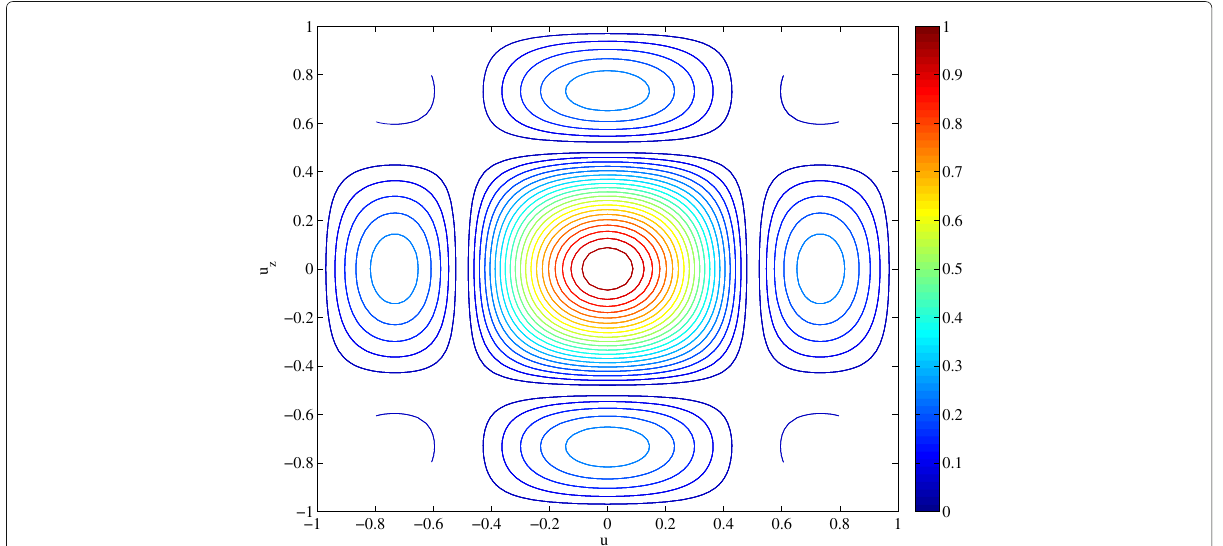
Fig. 6 Contour plot of magnitude of beam pattern for fixed antenna selection with UPA : M = 16, K = 6